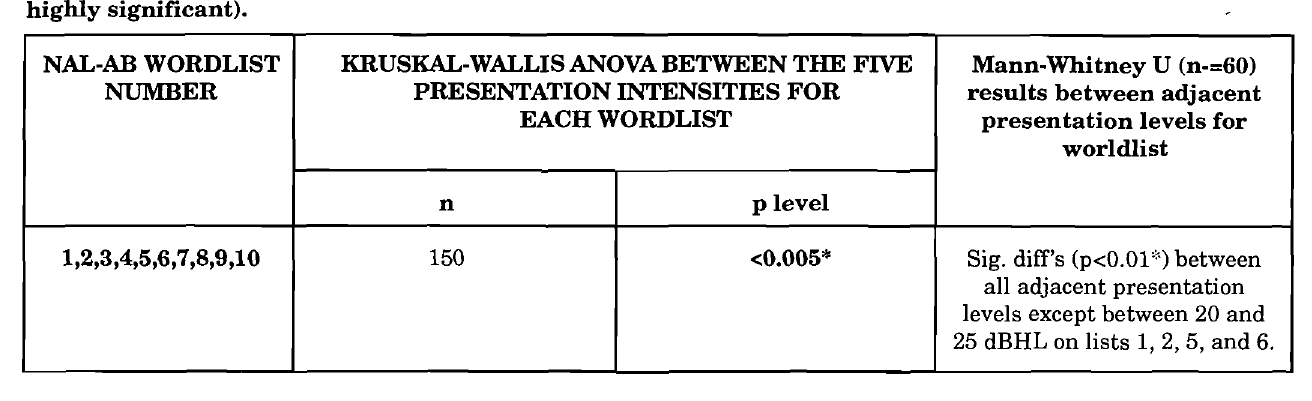
TABLE 3: Repeated measures, one way ANOVAresults for differences in South African English speakers' mean scores between NAL-AB wordlists, conducted for each presentation intensity separately (*-highly significant). J ,